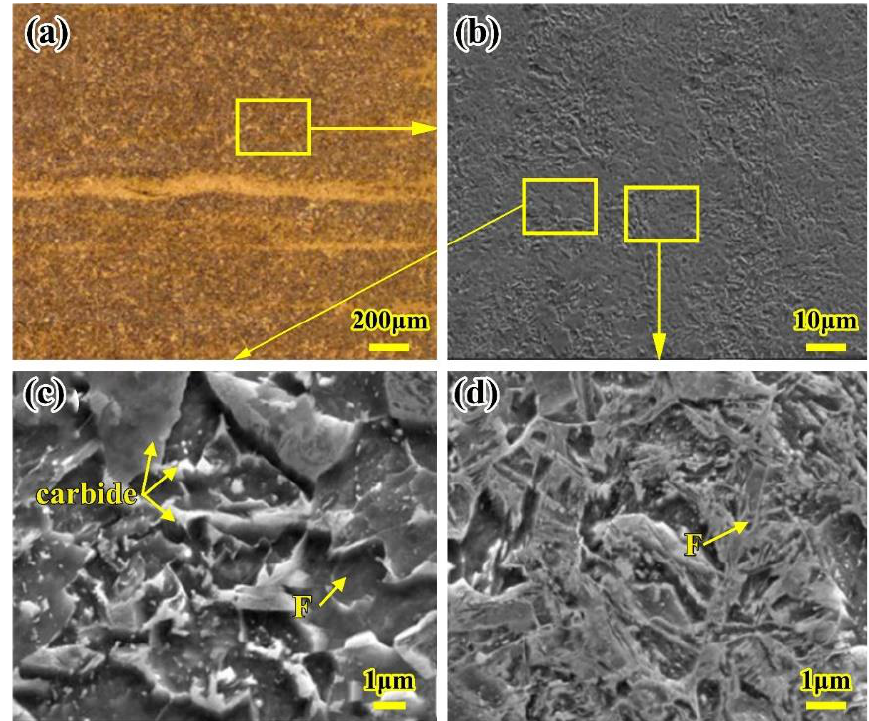
Figure 6. Microstructure of the TPZ of the LBW joint ( a ) Segregation band in the TPZ ( b ) Microstructure of the segregation band in SEM ( c ) Microstructure in black part ( d ) Microstructure in white part. F: ferrite.